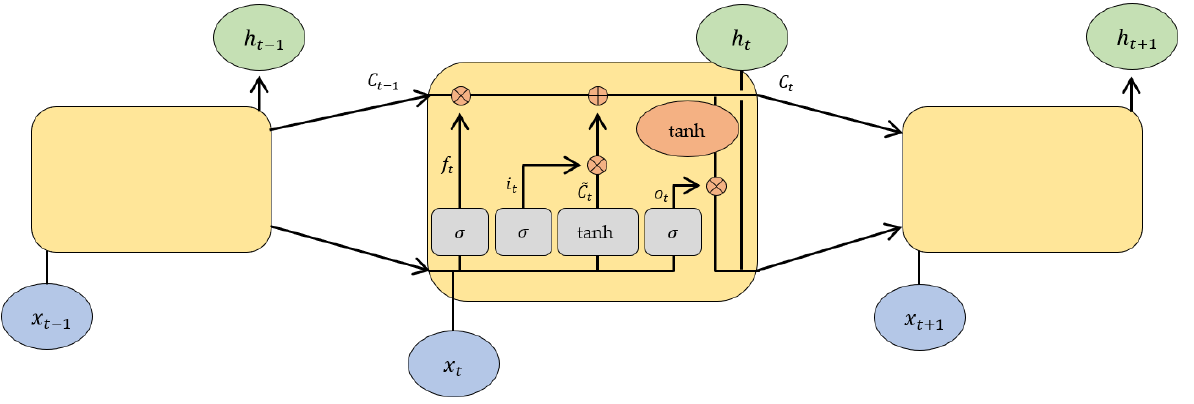
Figure 2. Long short-term memory network.